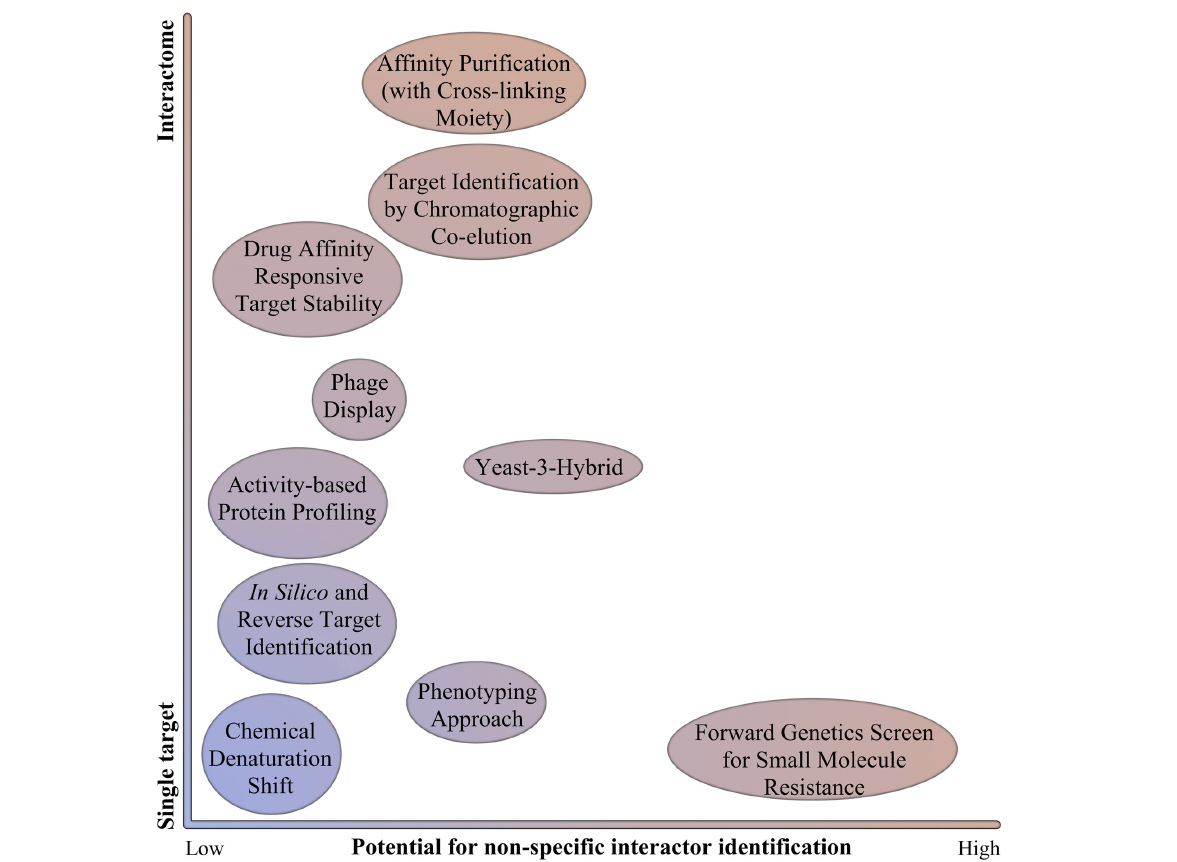
identify non-specific interactors (such as proteins that will confer resistance or induce the appropriate readout without actually binding specifically the small